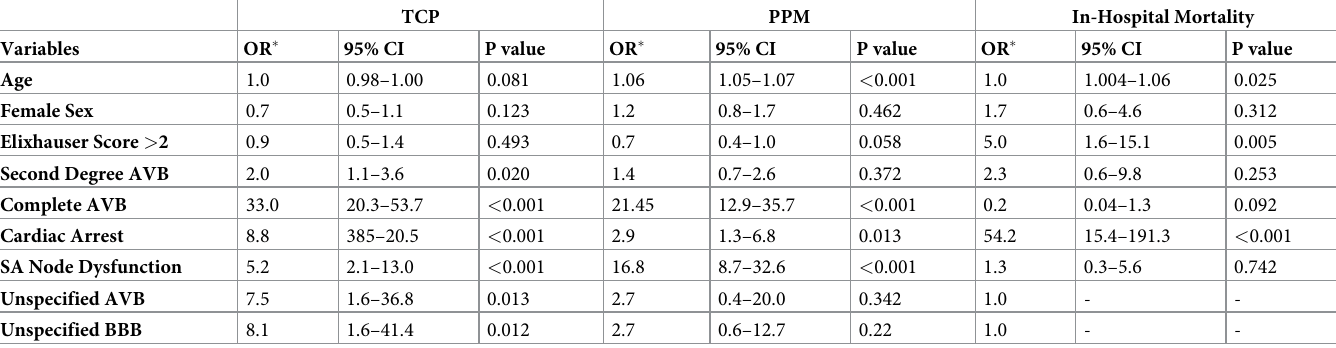
Table 6. Multivariable logistic regression: Predictors of TCP, PPM implantation, and mortality in the U.S. between 2003 and 2014. TCP PPM In-Hospital